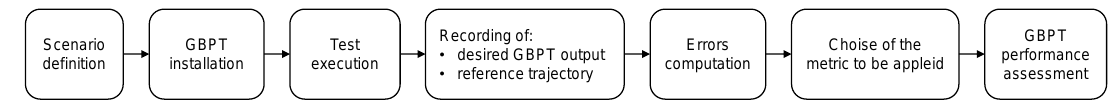
Figure 2. GBPT performance